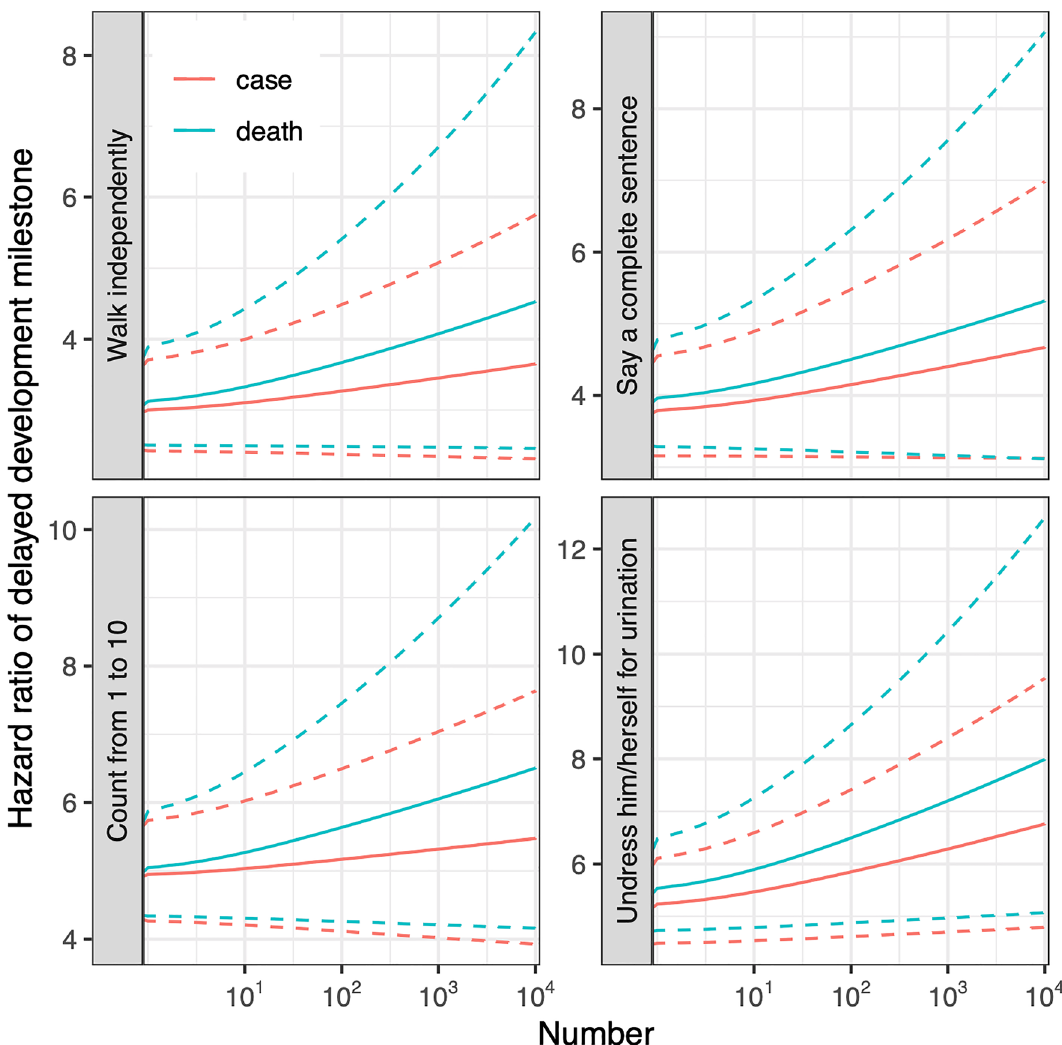
Figure 2. The association between SARS and delayed developmental milestone is enhanced by pandemic size. The pandemic size is indicated by the number of SARS cases (red) or deaths (blue) in a provincial area. The solid lines present how the hazard ratio for an association between SARS and a delayed milestone vary with the pandemic size; and the dashed lines present the 95% confidence ing SARS at 2-, 3- or 4-years-old was associated with a weight reduction of 4.86 kg (0.36, 9.35), 5.48 kg (0.56, 11.53) or 5.09 kg (− 2.12, 12.30), respectively. The modelling results with adjustment of different covariates are documented in Table S6. Similarly, in Beijing and Guangzhou, the effect at 3 years of age was estimated as a body weight reduction of 8.24 kg (1.86, 14.62), which was greater than that observed in other regions [6.61 kg (0.27, 12.95); P value = 0.0006 for the likelihood ratio test of the null hypothesis that the overall effect was identical between regions, as shown in Table S7]. The association between SARS and body weight reduction might also reflect the pandemic’s effect on delayed development. No significant effects for SARS maternal on weight or height were identified. Preterm birth and birthweight.